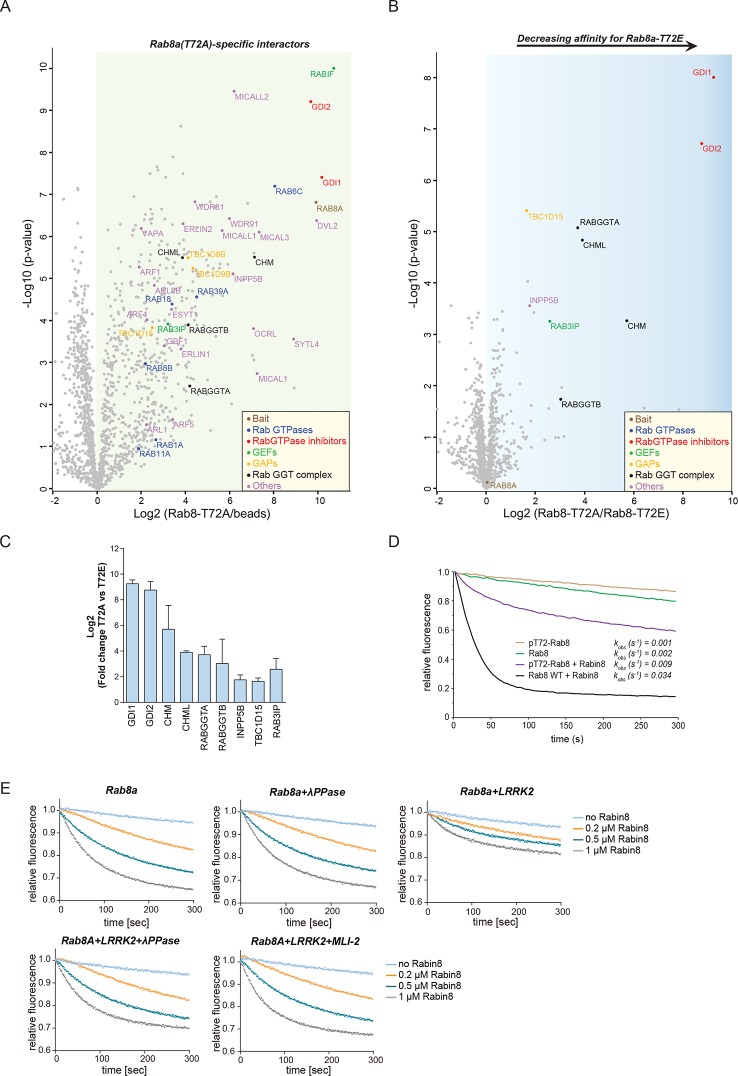
LRRK2 controls the interaction of Rabs with regulatory proteins.(A) Volcano plots showing interactors of GFP-Rab8a (T72A) transiently expressed in HEK293 cells and (B) Proteins differentially binding to T72A as compared to T72E. (C) Fold changes (T72A/T72E, n=4) of regulated proteins shown in (B). (D) Kinetic measurements of the dissociation of mant-GDP from non-phosphorylated and T72 phosphorylated Rab8a by Rabin8. Observed rate constants (kobs) are indicated for each reaction and data points represent mean (n=3). (E) Measurements of mant-GDP dissociation from LRRK2 phosphorylated Rab8a by Rabin8 in absence or presence of λ-phosphatase (λ-PPase) or MLI-2 (1 µM). Error bars are mean ± SD of replicates.